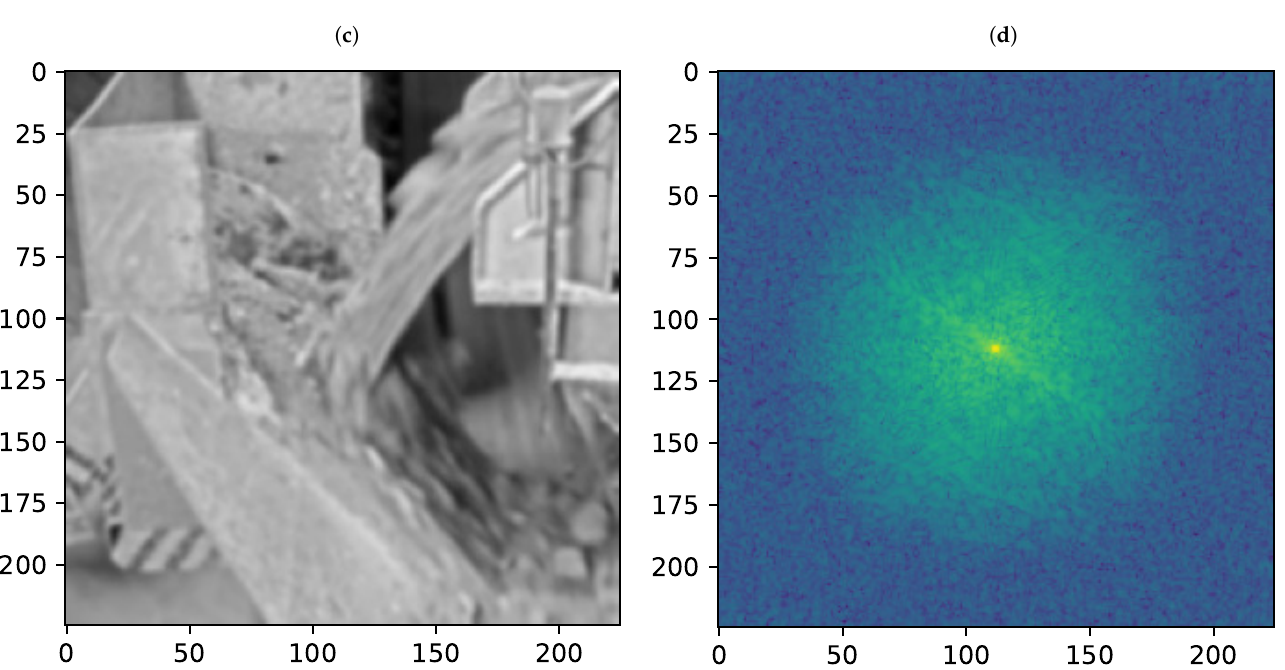
Figure 6. Filtering with the use of Gaussian blur of the image of the normal operation of the transfer point: ( a ) normal conditions; ( b ) normal conditions spectrum; ( c ) normal conditions filtered out; ( d ) normal conditions filtered out